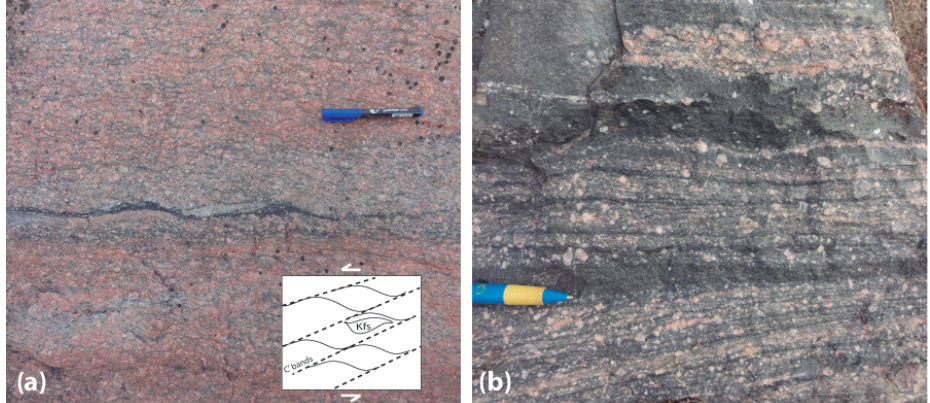
Figure 2. Field observations of shear zones in mylonitic granitoids of the Pernambuco shear zone. (a) Fine-grained feldspar aggregates in shear bands; the inset highlights the geometrical relationship of the foliation and C’ bands. (b) Two-feldspar mixtures characterized by fine-grained feldspar grains, feldspar porphyroclasts and quartz ribbons.